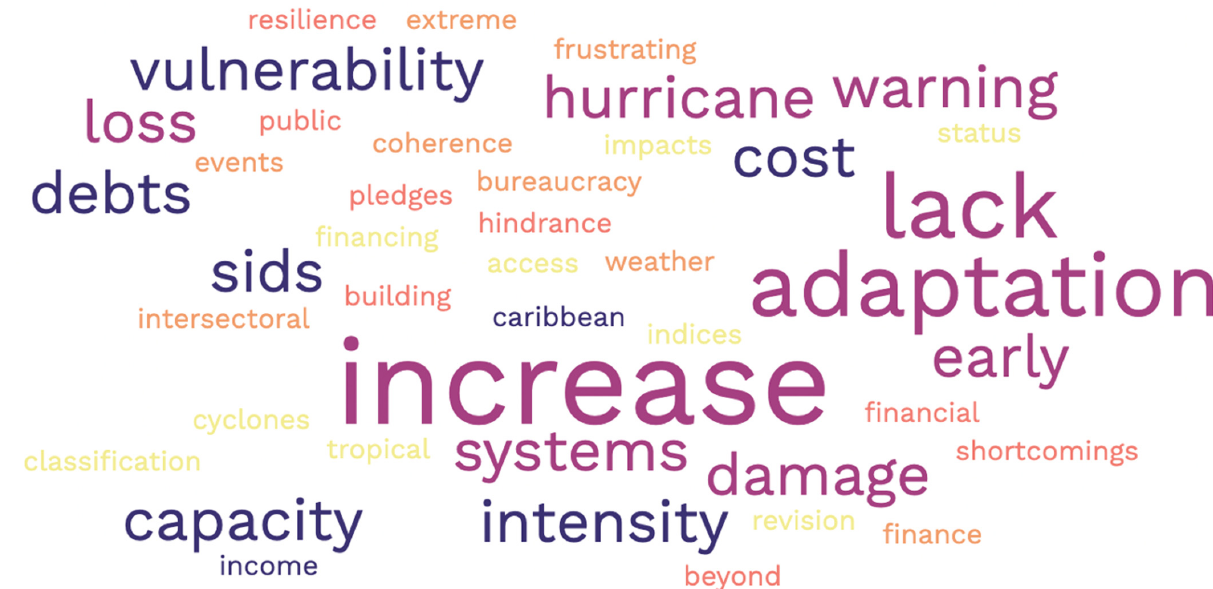
Figure 6. Keyword analysis map from interview.